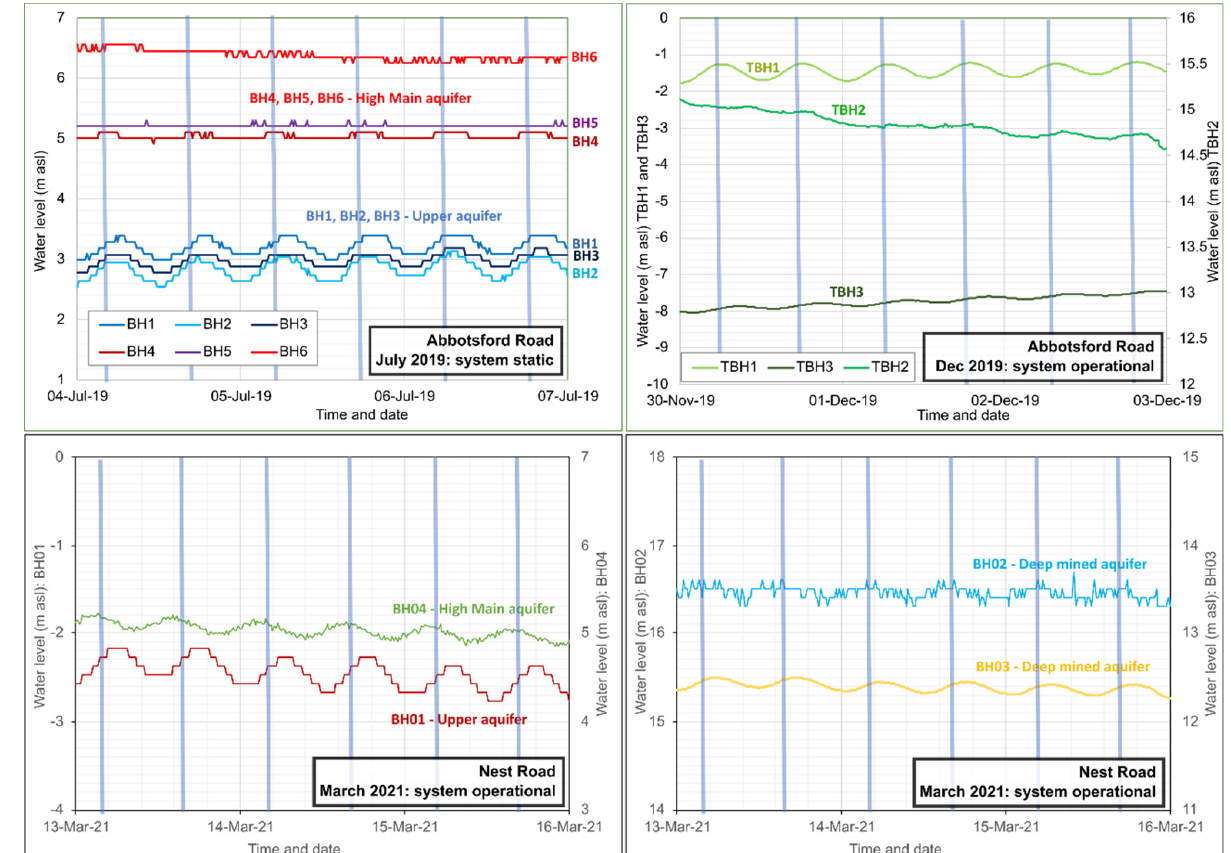
Figure 7. Tidal maxima recorded at the mouth of the Tyne Estuary at North Shields are shown as vertical blue bars. Hydrographs of specific periods have been selected based on ( a ) a good operational signal being received from all sensors, and ( b ) no interference from pumping switch-on/off. The selected periods are thus either static periods or periods of continual operation. The apparent “spikiness” or “quantisation” of some responses is related to the signal resolution logged by BMS.